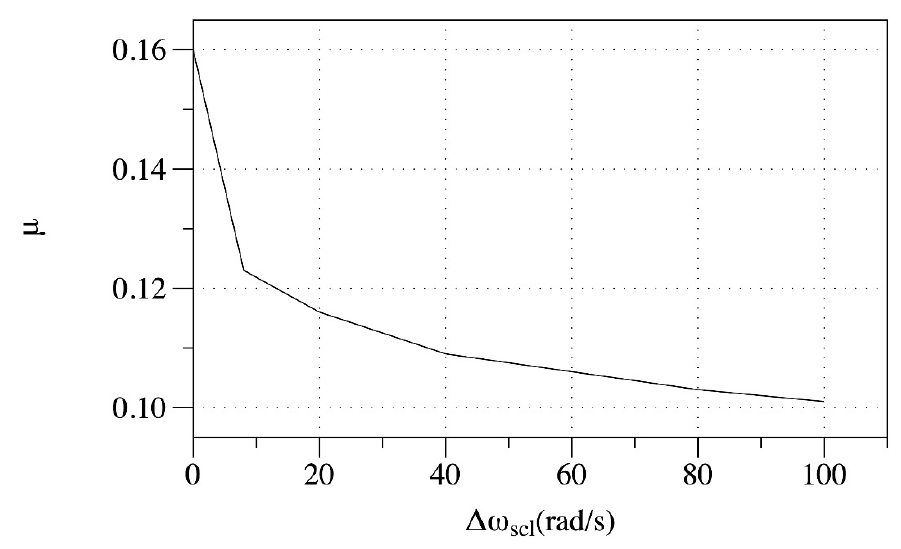
ffi cient characteristics of clutch Figure 6. Friction coefficient characteristics of clutch pads. Figure 6. Friction coe